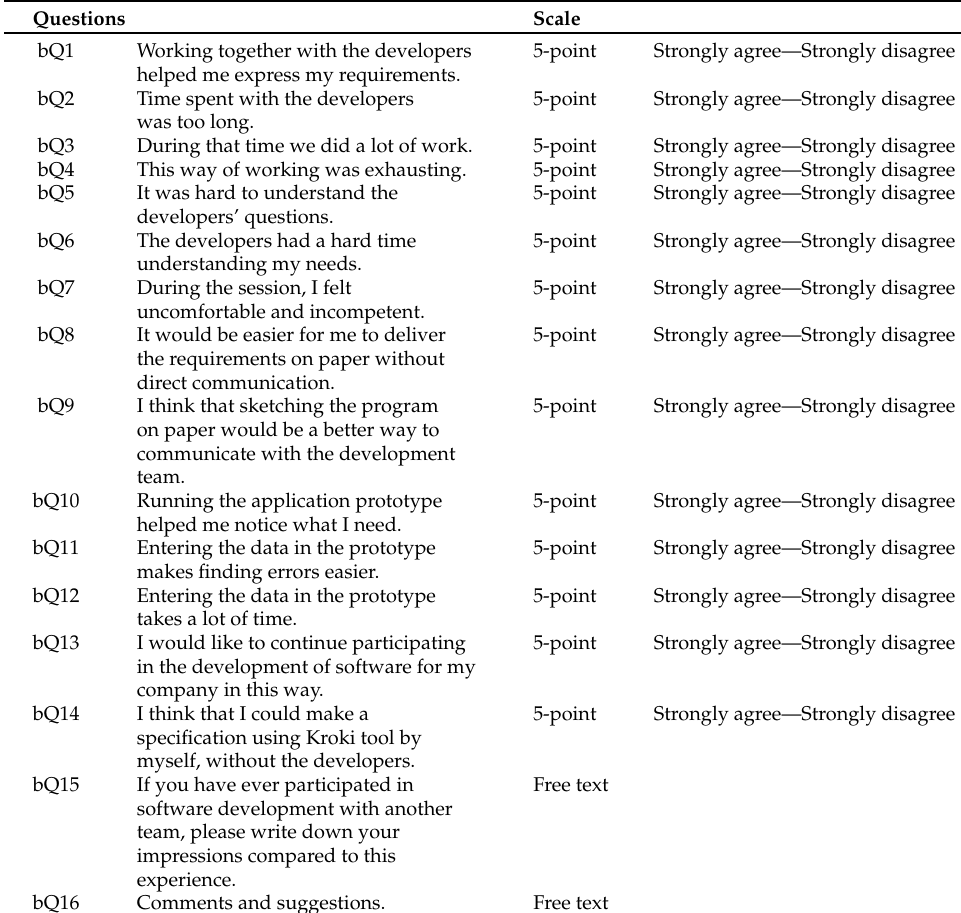
Table 3. Development sessions evaluation questionnaire.